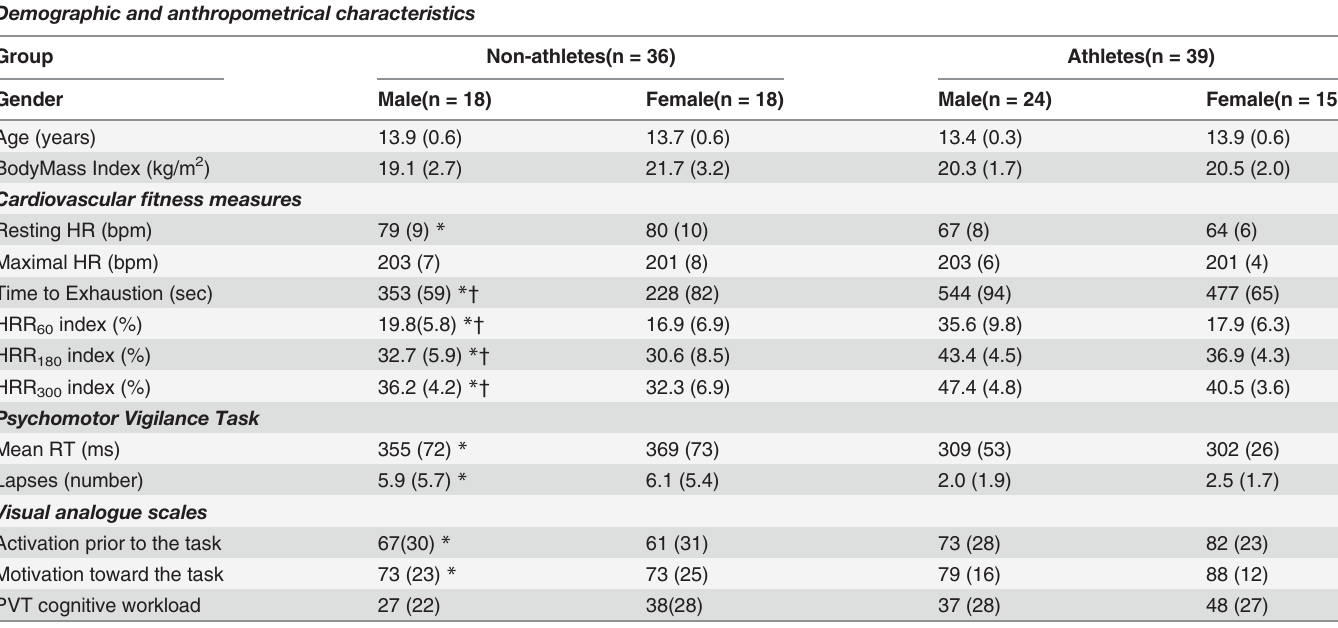
Table 1. Mean (SD) of participants ’ demographic, fitness, PVT results and scores in the visual analogue scales. Demographic and anthropometrical characteristics